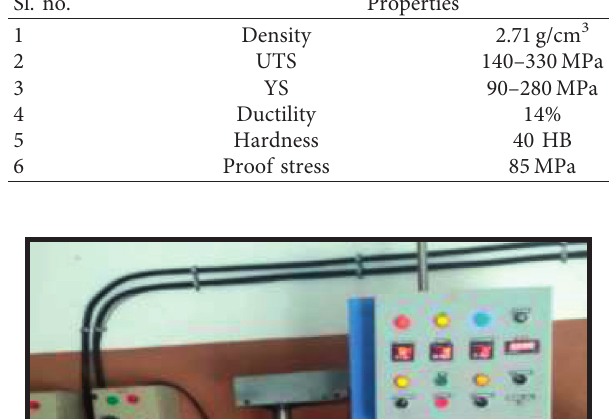
Table 2: Characteristics of AA6082 aluminum. Sl. no.